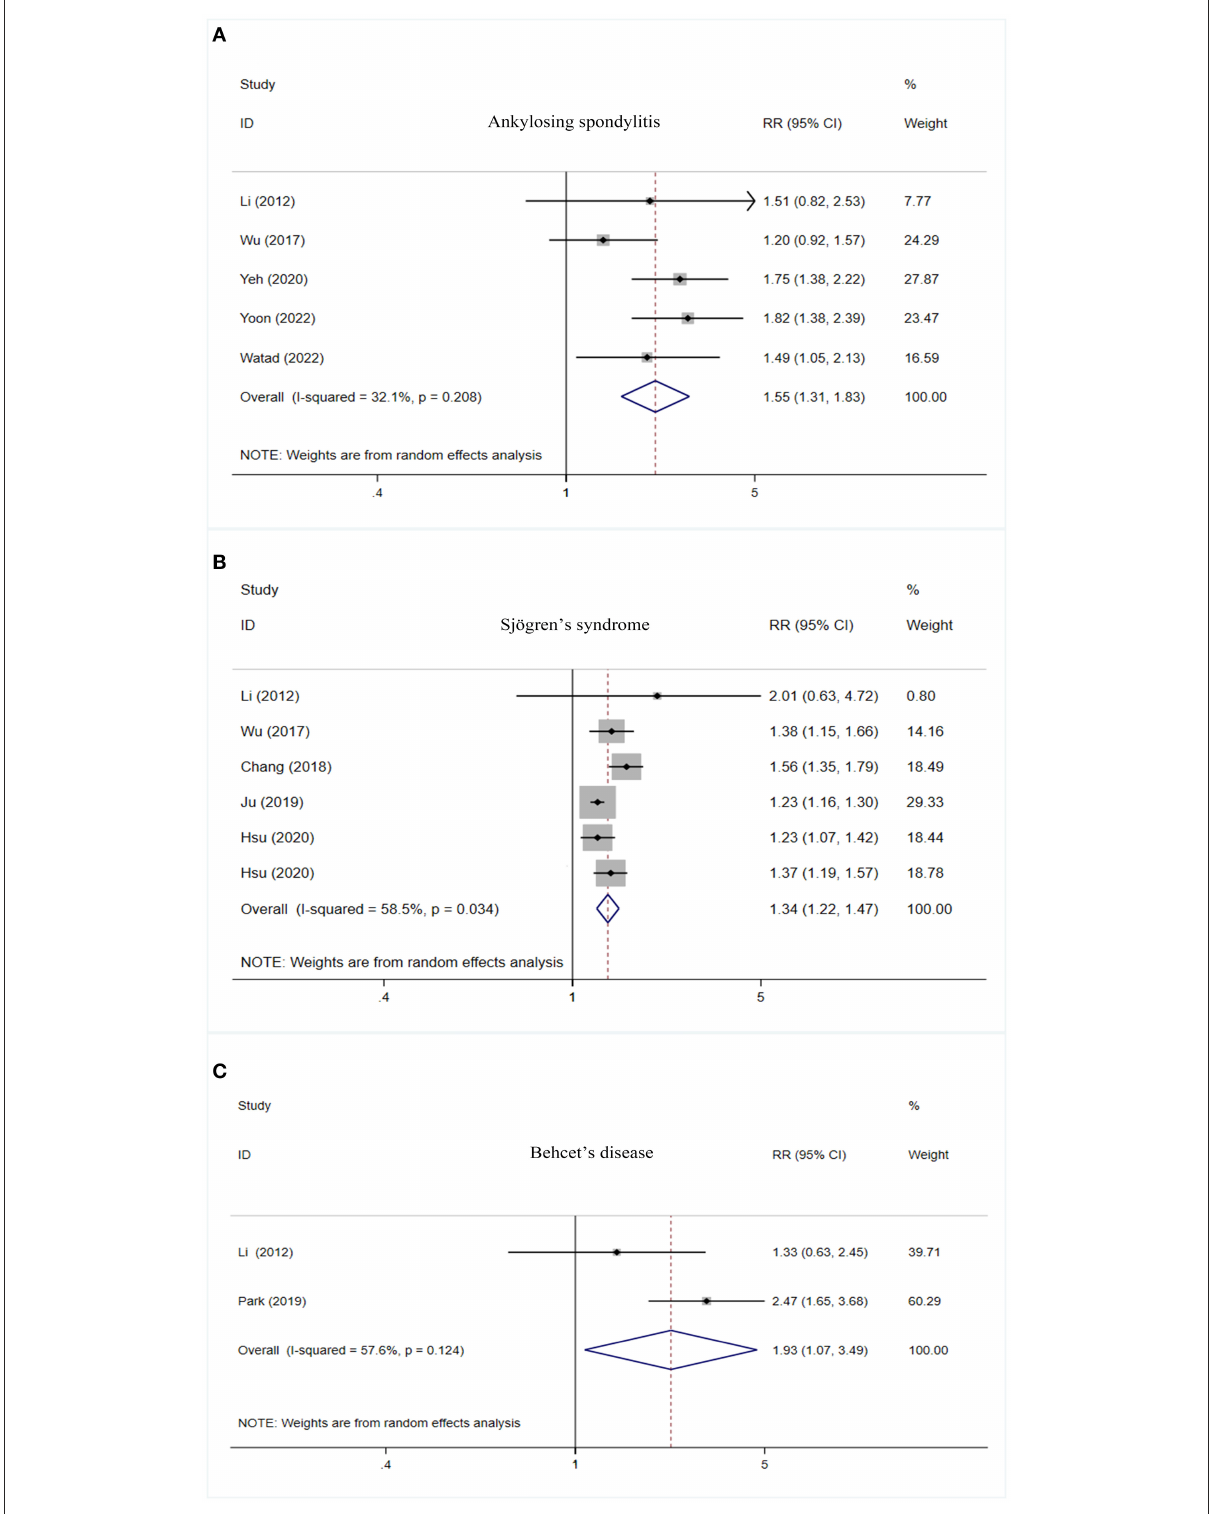
FIGURE2 Forest plot of PD risk in patients with ankylosing spondylitis (A) , Sjögren’s syndrome (B) , and Behcet’s disease (C) . PD, Parkinson’s disease; CI, confidence interval; RR, relative